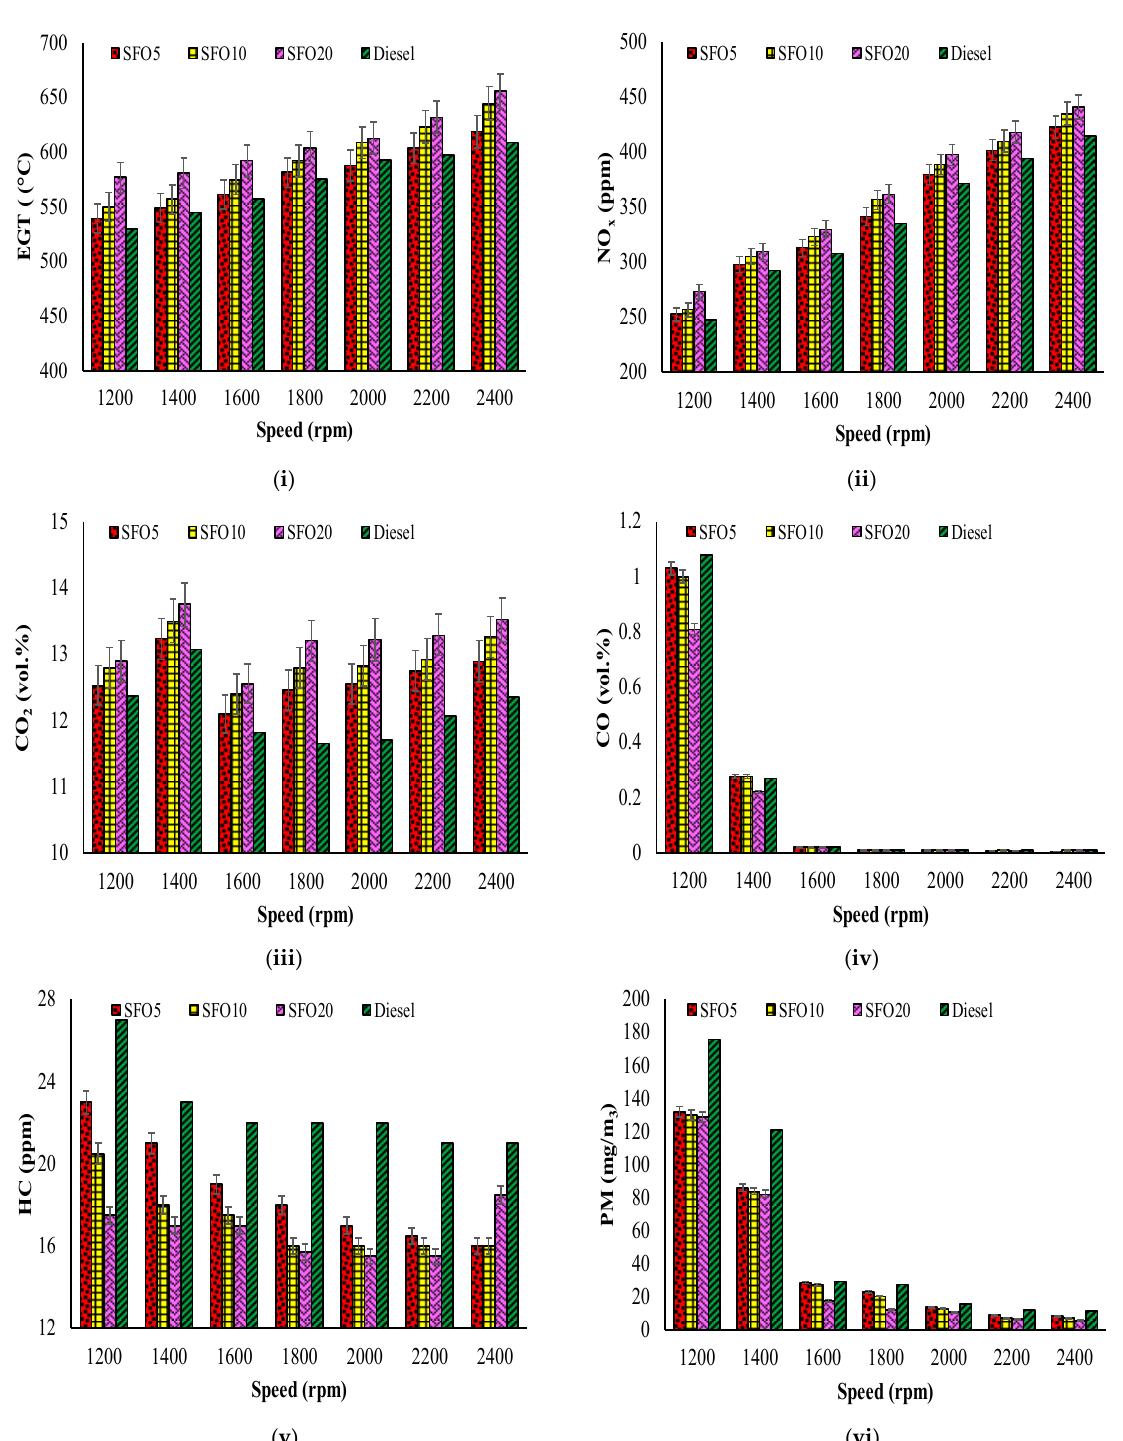
Figure 6. Variation in engine emissions with engine speeds.